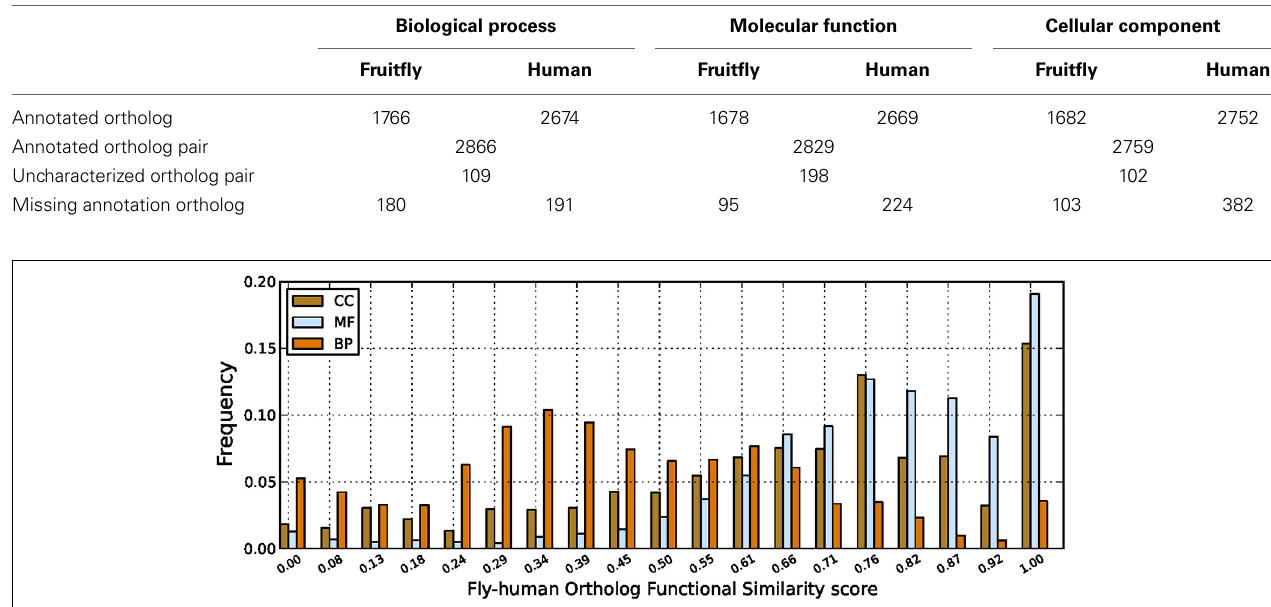
Table 3 | General features of fruitfly-human ortholog proteins in terms total number of ortholog proteins with GO annotations in BP, MF, and CC ontologies for different genomes under consideration.